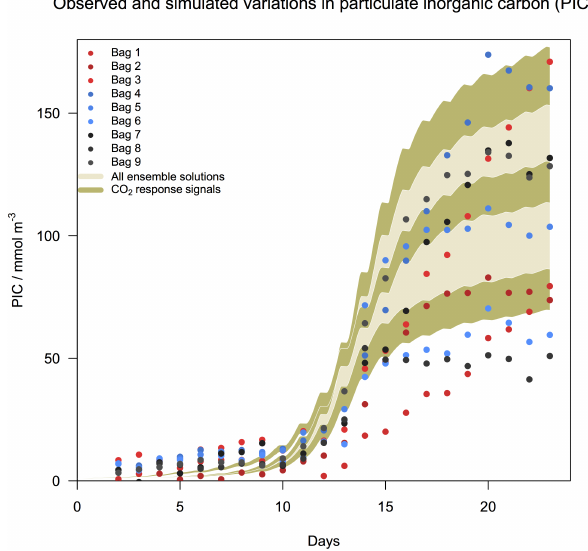
Figure 14. Full spread of model solutions according to credible range in parameter estimates, including ensemble solutions of high, medium, and low calcification (light brown shaded area). Symbols represent observations of all mesocosms. Khaki shaded bands show CO 2 effect in the model, for solutions with lowest, medium, and highest calcification